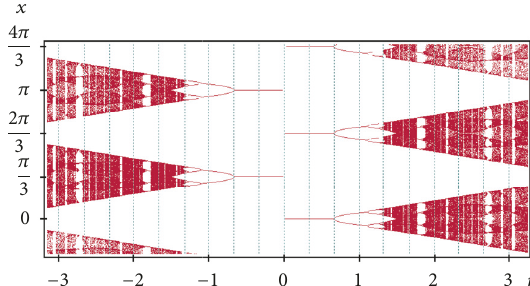
Figure 4: The figure shows a bifurcation diagram for the iterative map 𝑥 𝑛+1 = 𝑥 𝑛 − 𝜅 cos 4 ( sin (3𝑥 𝑛 )) sin (3𝑥 𝑛 ) ; an alternating sequence of tree-like graphs goes upwards and downwards. Here are depicted the options for 0 < 𝜅 < 2/3 and antioptions for −2/3 < 𝜅 < 0 . Stable fixed points bifurcate in a 2-cycle for 𝜅 = 2/3 ; then a cascade of bifurcations appears, leading to chaos. The 2-cycle may model a dilemma, since agent’s opinion jumps from one posture to another. Other 𝑛 -cycles may model other doubt processes in agents.